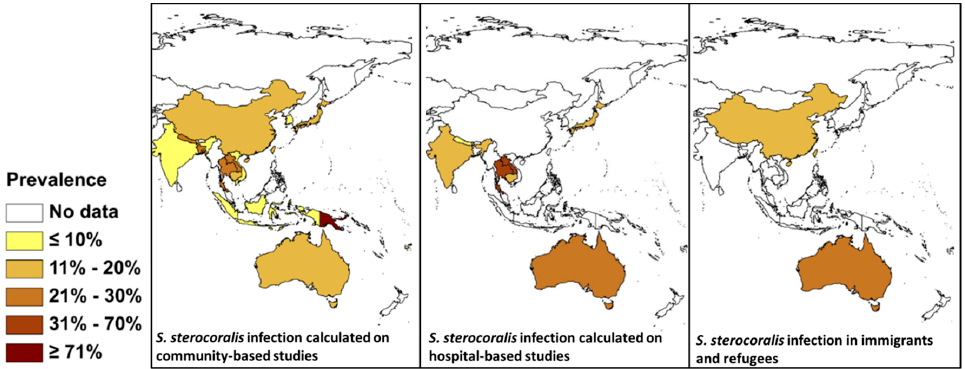
Figure 3. Prevalence of S. stercoralis in Asia and Australia based on community-based studies, hospital-based studies, and prevalence in immigrants and refugees. Modified from Schäret al., [84] .